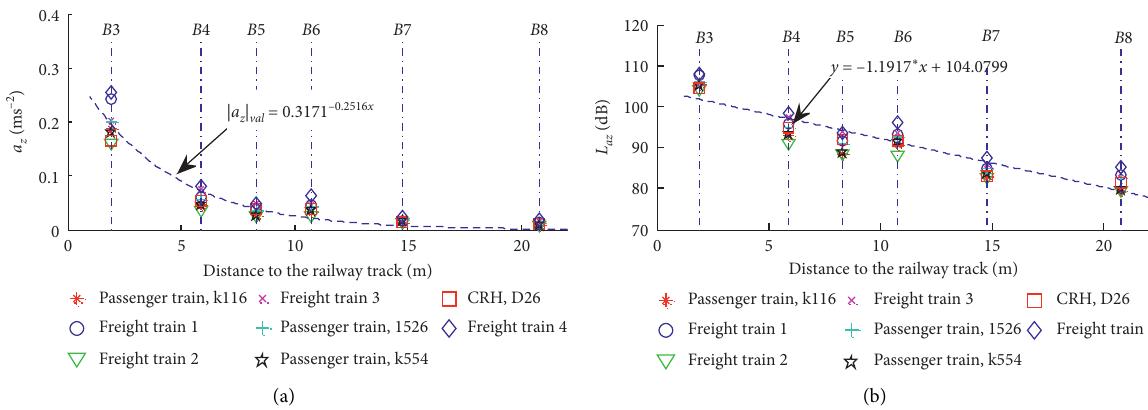
Figure 4: Fitting curve of the vibration level attenuation mechanism in the unfrozen period: (a) effective value of acceleration and (b) acceleration shows that the effective values of vibration acceleration of these trains at B 3 were 0.2492 and 0.167 m/s 2 , respec- tively, and the vibration levels were 105.2 and 107.8 Hz,